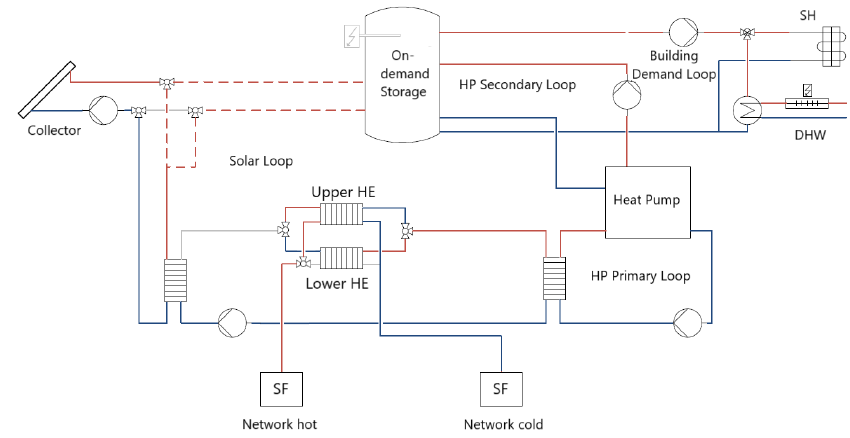
Figure 6. Single building model with one decentralized storage (Figure modified from